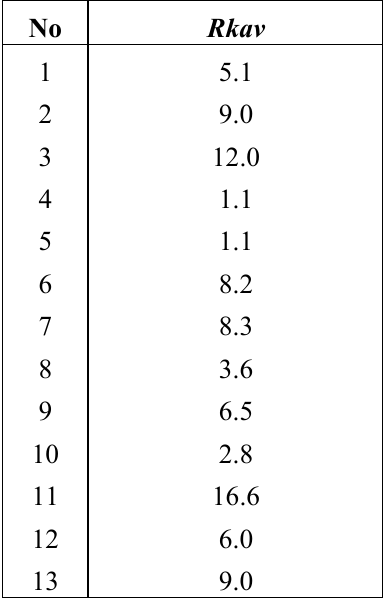
Table 8 . Averaged rank calculated according to eqn. 4 Based on Tux Boxes and PASSS (HPOR approach) (n/a: calculations not available)